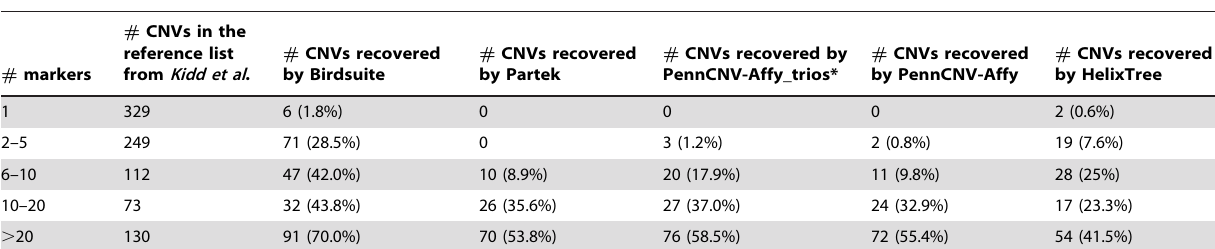
Table 1. The recovery rates of each of the CNV-calling programs depending on CNV length based on data of Kidd et al.